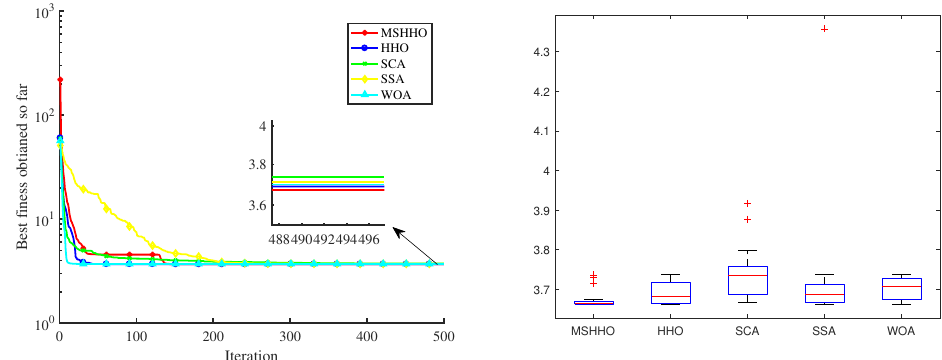
Figure 13. Qualitative results of spring design